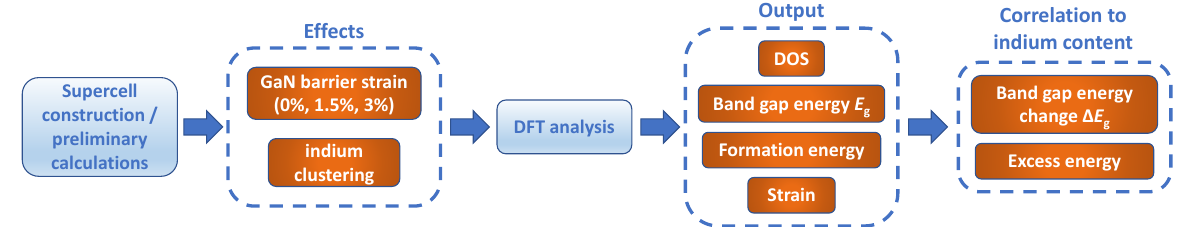
Figure 2. Block diagram illustrating the adopted methodological approach for studying influences of strain and clustering, and correlation of the results to the indium content of quantum wells.